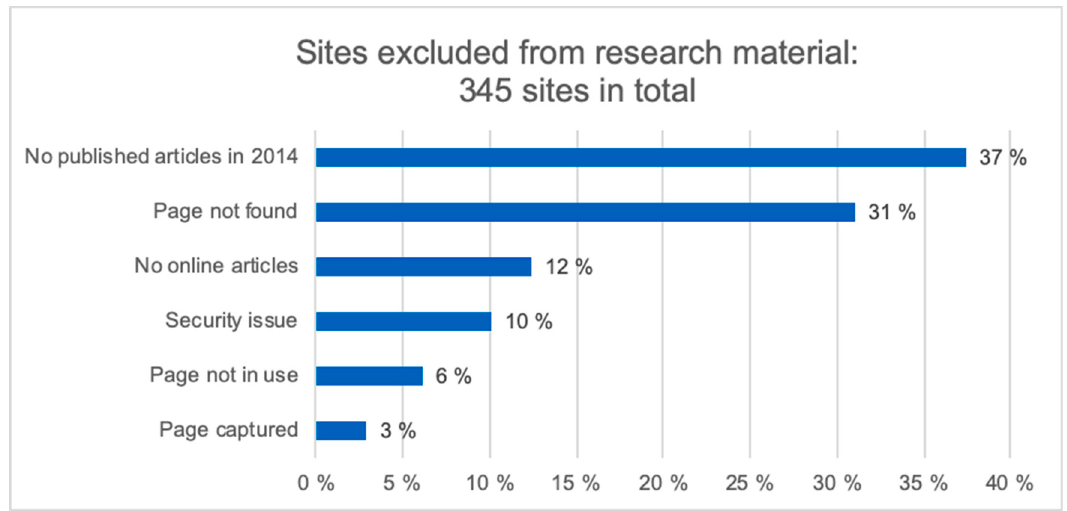
Figure 1. Reasons for excluding journals in the initial random set.